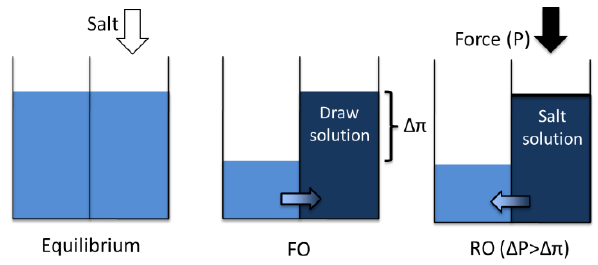
Figure 1. Schematicofforwardosmosis(FO)andreverseosmosis(RO); ∆ π Figure 1. Schematic of forward osmosis (FO) and reverse osmosis (RO); Δπ is the osmotic pressure gradient.